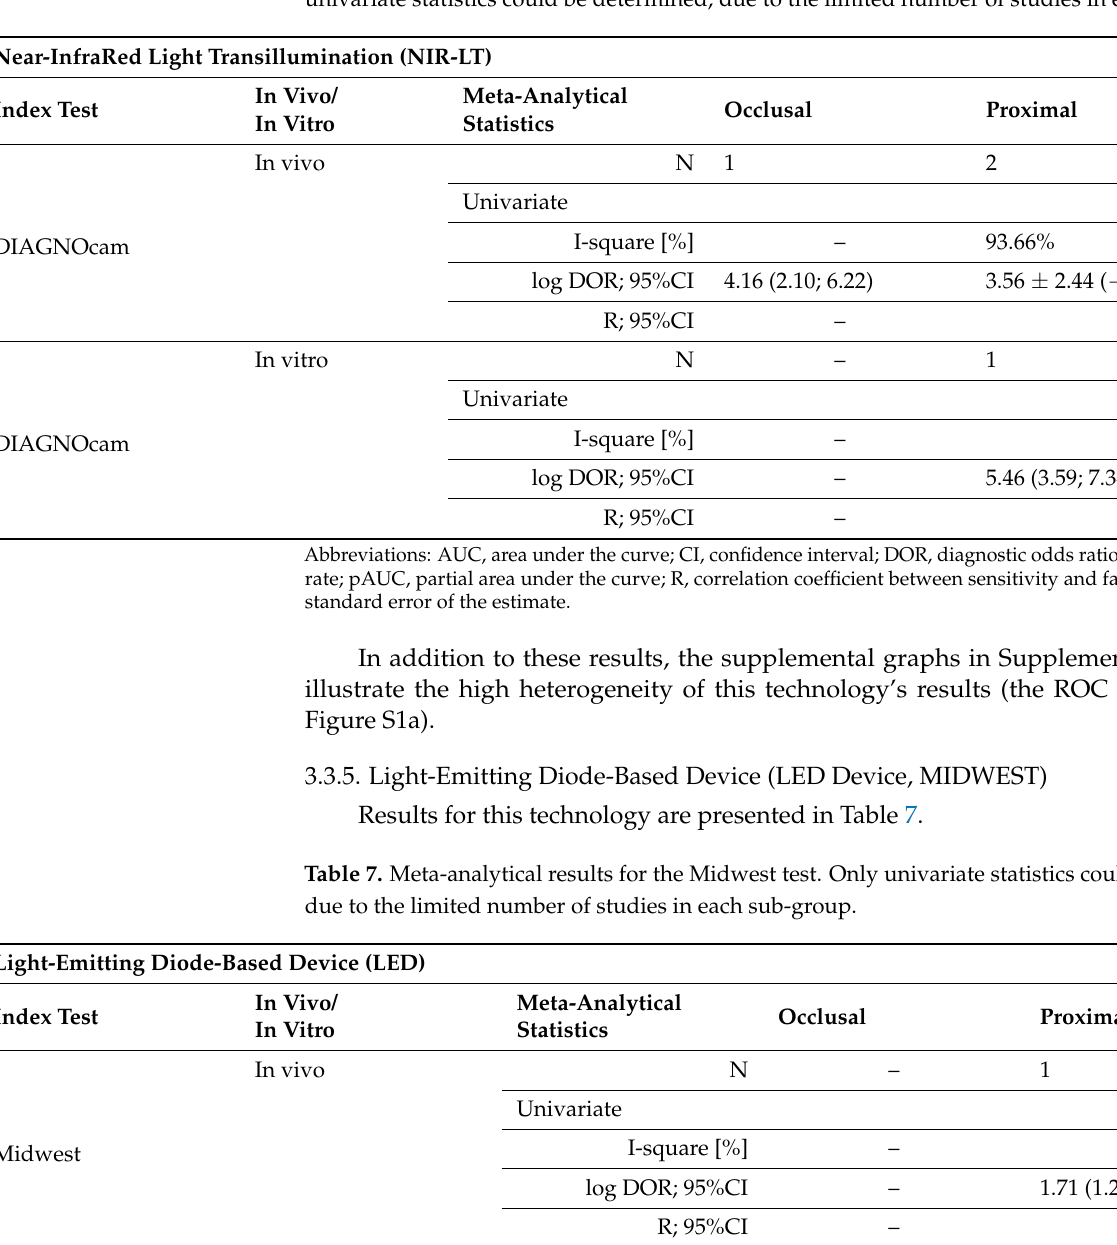
Table 6. Meta-analytical results for the near-infrared light transillumination (DIAGNOcam) test. Only univariate statistics could be determined, due to the limited number of studies in each sub-group.